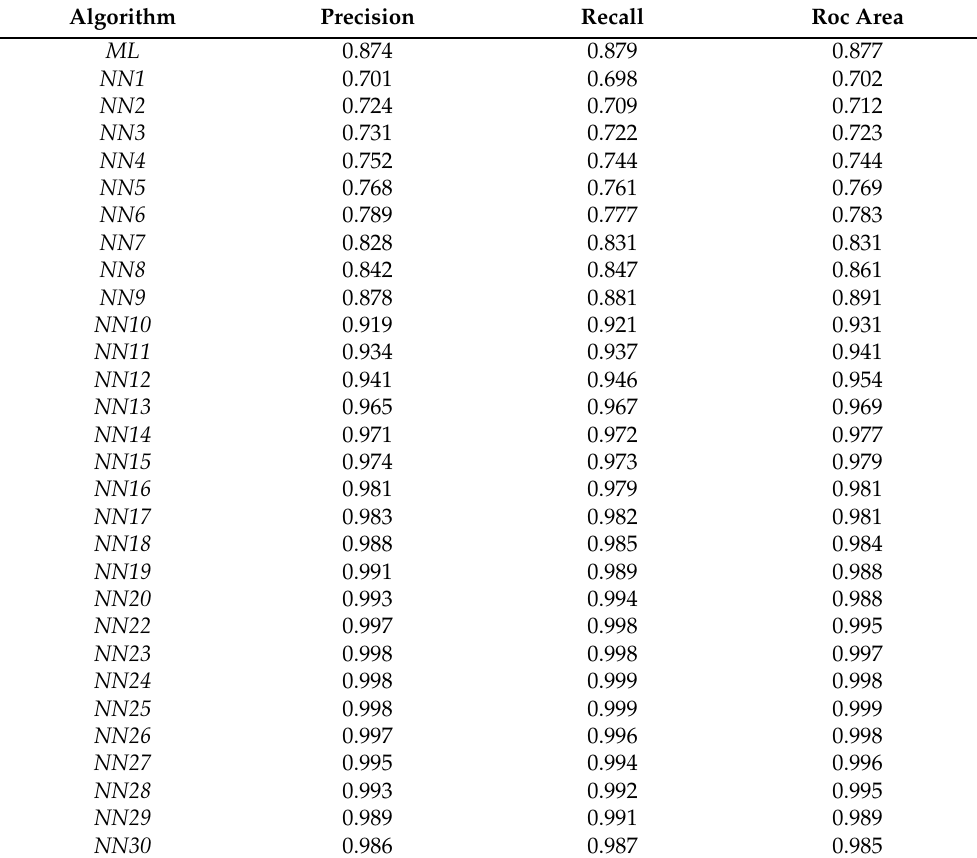
Table 3. Classification Results. Algorithm